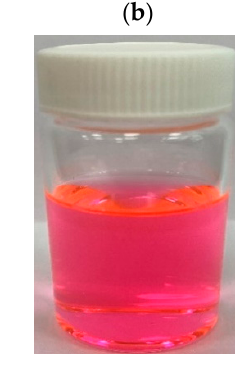
Figure 1. ( a ) The marine algae Pyropia yezoensis ; ( b ) purified R-phycoerythrin.